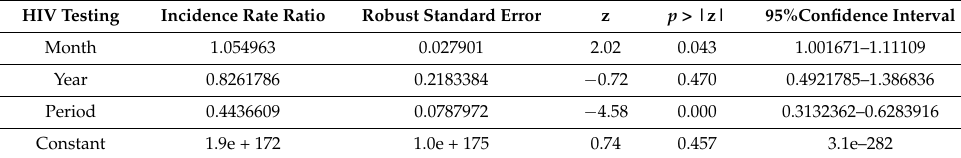
Table 3. Uptake of HIV testing and counseling before and during COVID-19.